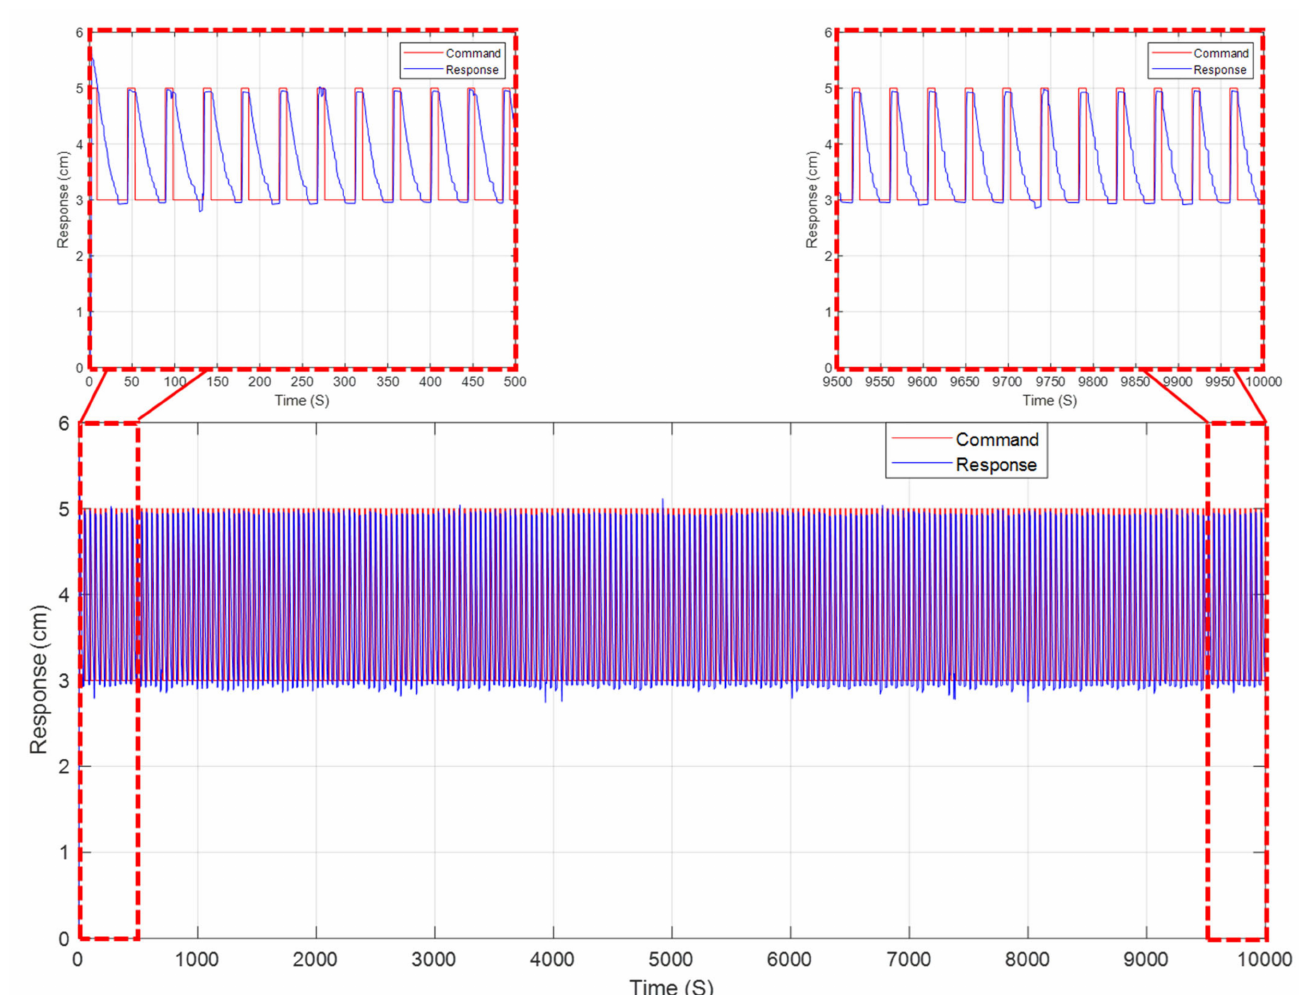
Figure 16. Long-duration displacement response of a square wave command